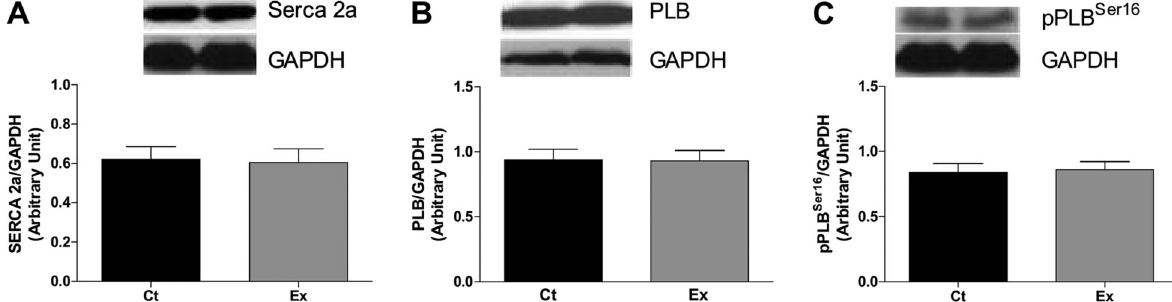
Figure 6. Densitometric analysis of the Western blot for ( A ) SERCA2a, ( B ) phospholamban PLB, and pPLB Ser16 ( C ) from controls (Ct, n=6) and exercised (Ex, n=6) spontaneously hypertensive rats (SHR). Results are reported as means ± SE. P 4 0.05 (Student ’ s t